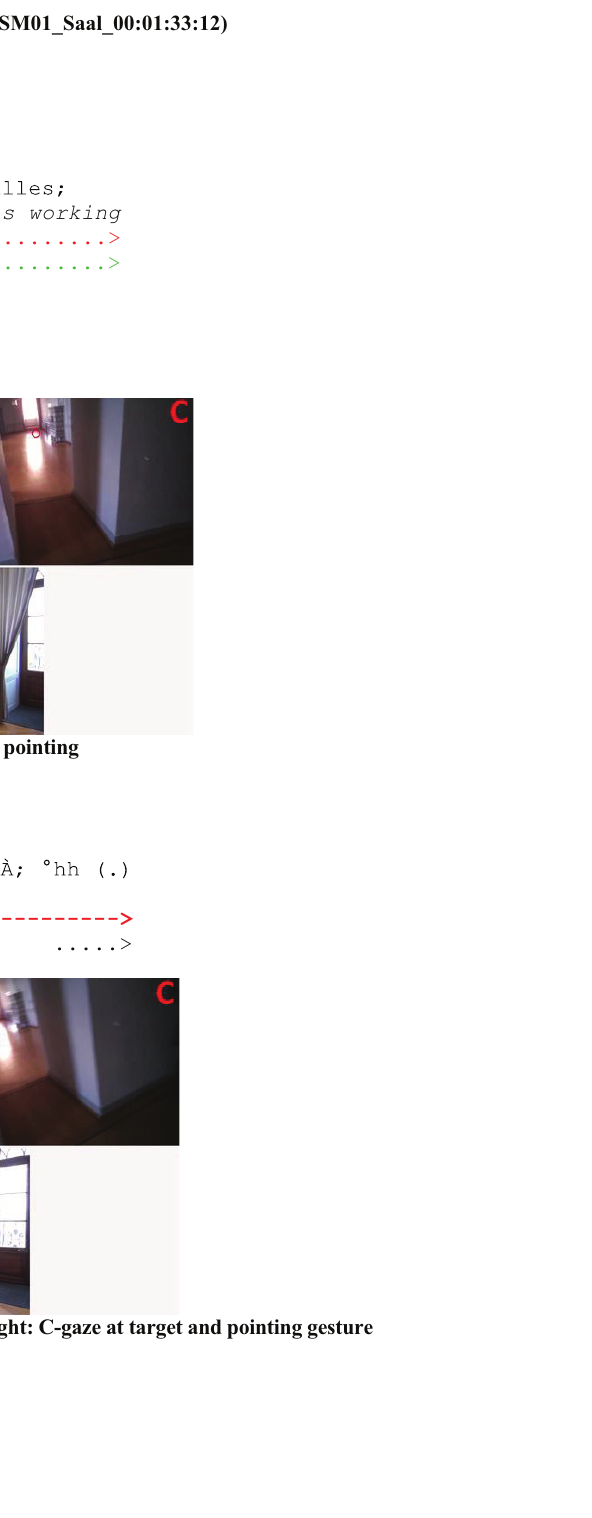
Figure 16, left: T-gaze at domain of scrutiny; right: C-gaze at target and pointing